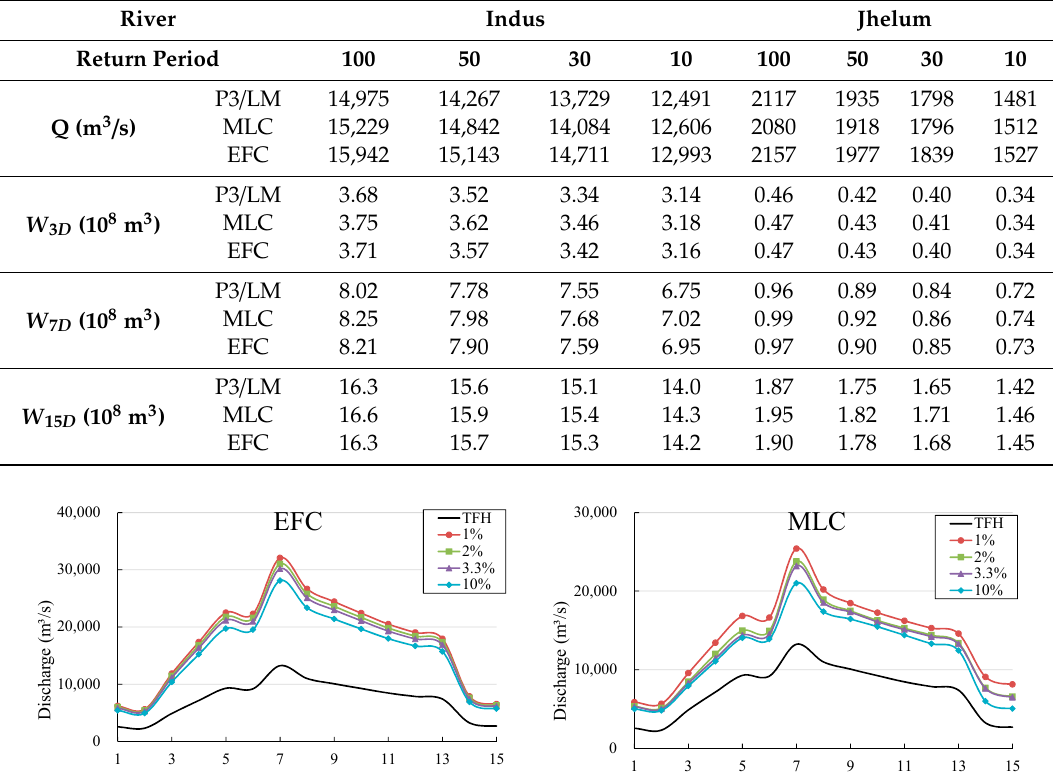
Table 5. Comparison of flood quantiles estimated by di ff erent methods.